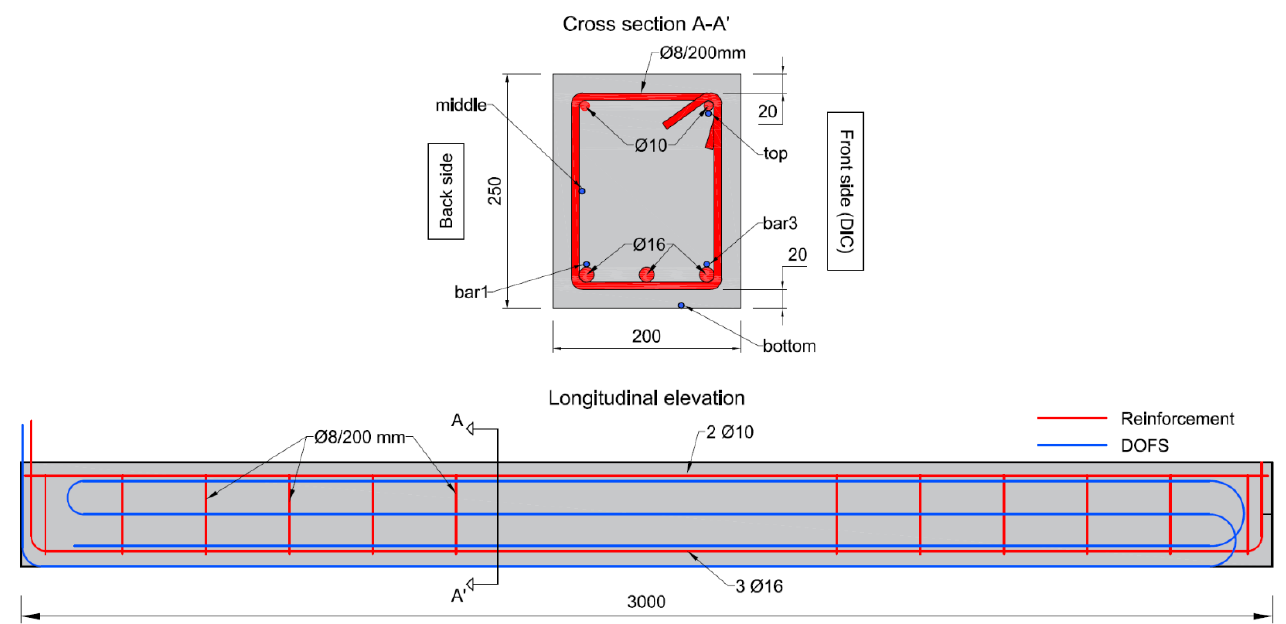
Figure 1. Geometry of the beam specimens, reinforcement layout and DOFS configuration (all measurements in mm).